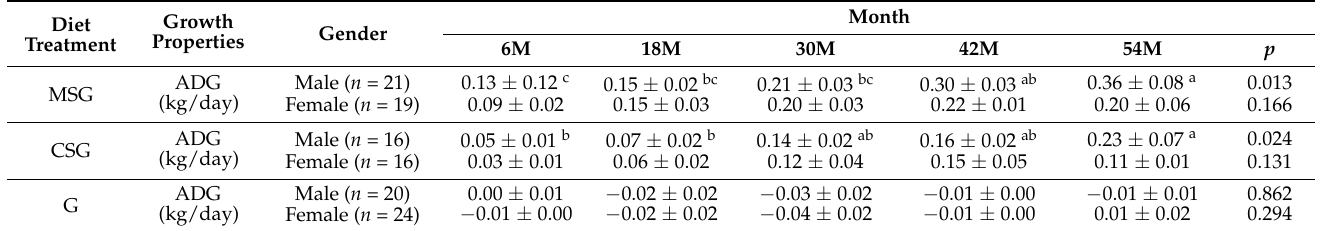
Table 3. The average daily gain of Tianzhu white yaks various with ages.